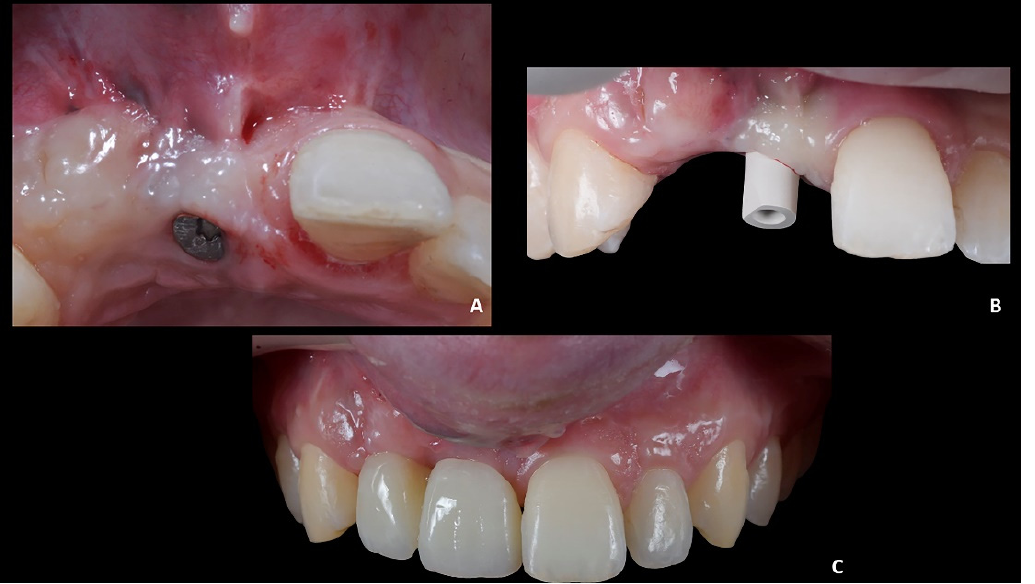
Figure 11. Case 2. ( A ) Healing abutment; ( B ) intra-oral scan with scan-body to detect the axial orientation of the implant; ( C ) prosthetic restoration.